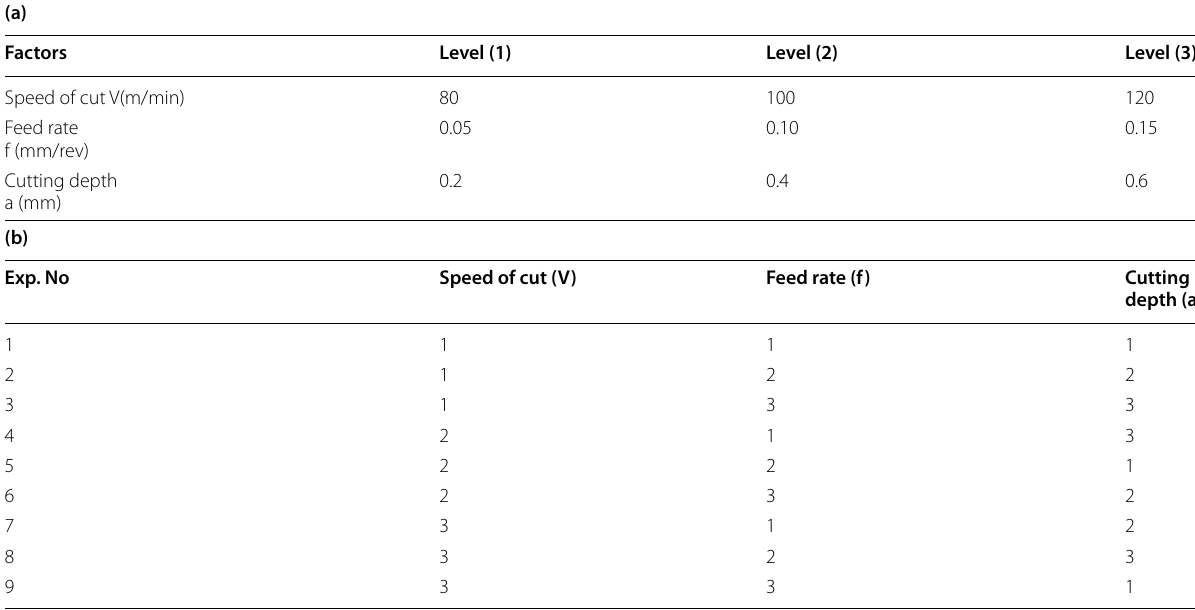
Table 2 (a) Parameters and their levels of the work, (b) the orthogonal array L9 by Taguchi technique (a) Factors Speed of cut V(m/min) Feed rate f (mm/rev) Cutting depth a (mm)